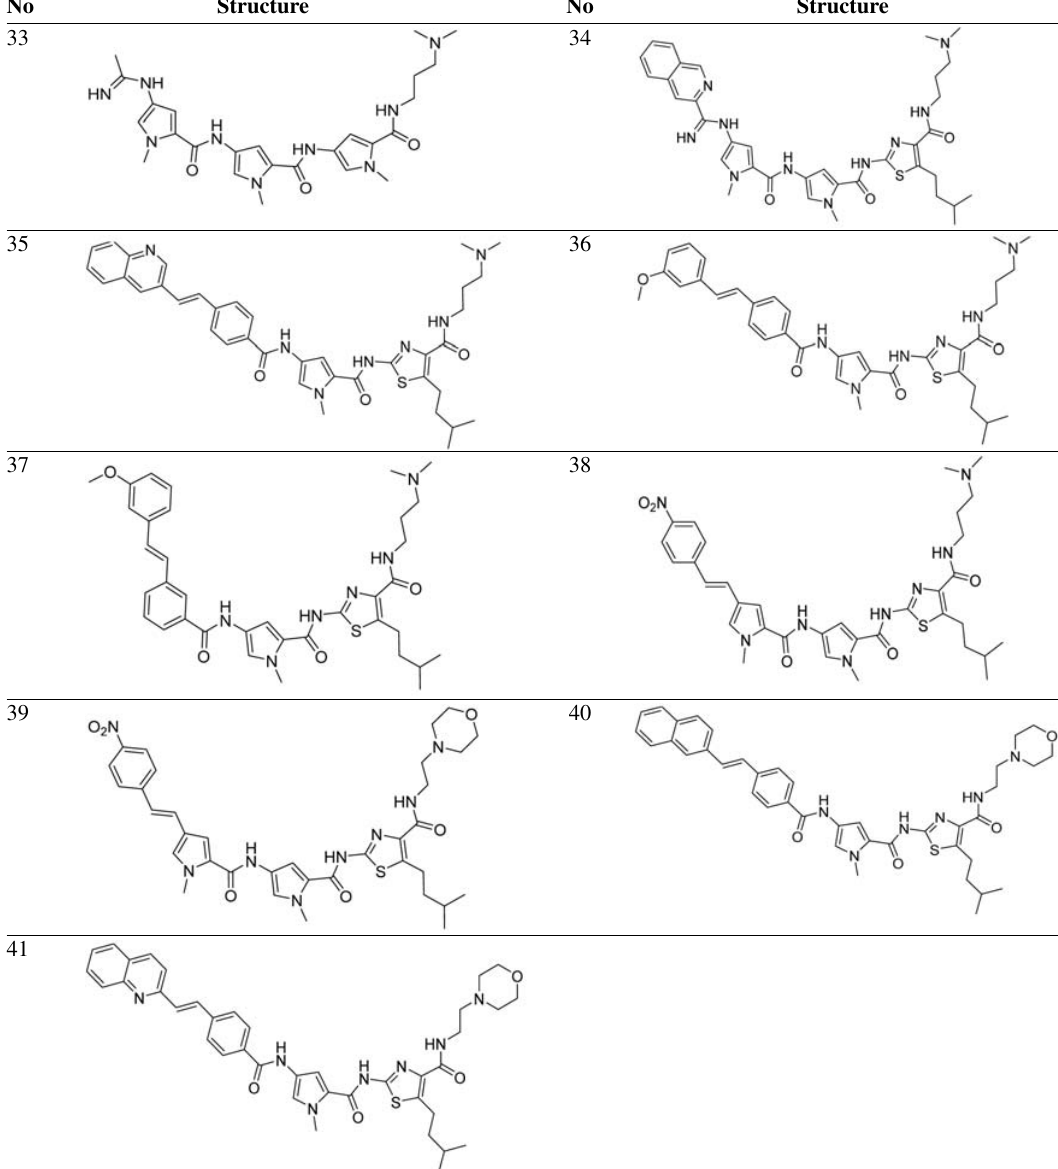
Table 5. Representative examples of S-MGB Structures: Anti-malarial minor groove binders